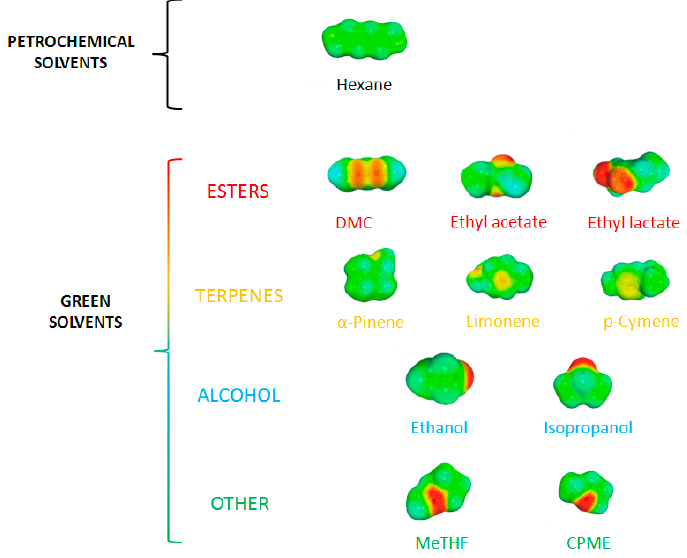
Figure 9. Modelization of solvents by COSMO-RS show the polarity in the surface of solvents. Relative solubility is always calculated in infinite dilution. The logarithm of the best solubility is set to 0, and all other solvents are given relatively to the best solvent. A solvent with a log 10 ( x j ) value of − 1.00 yields a solubility that decreased by a factor 10 compared to the best solvents.